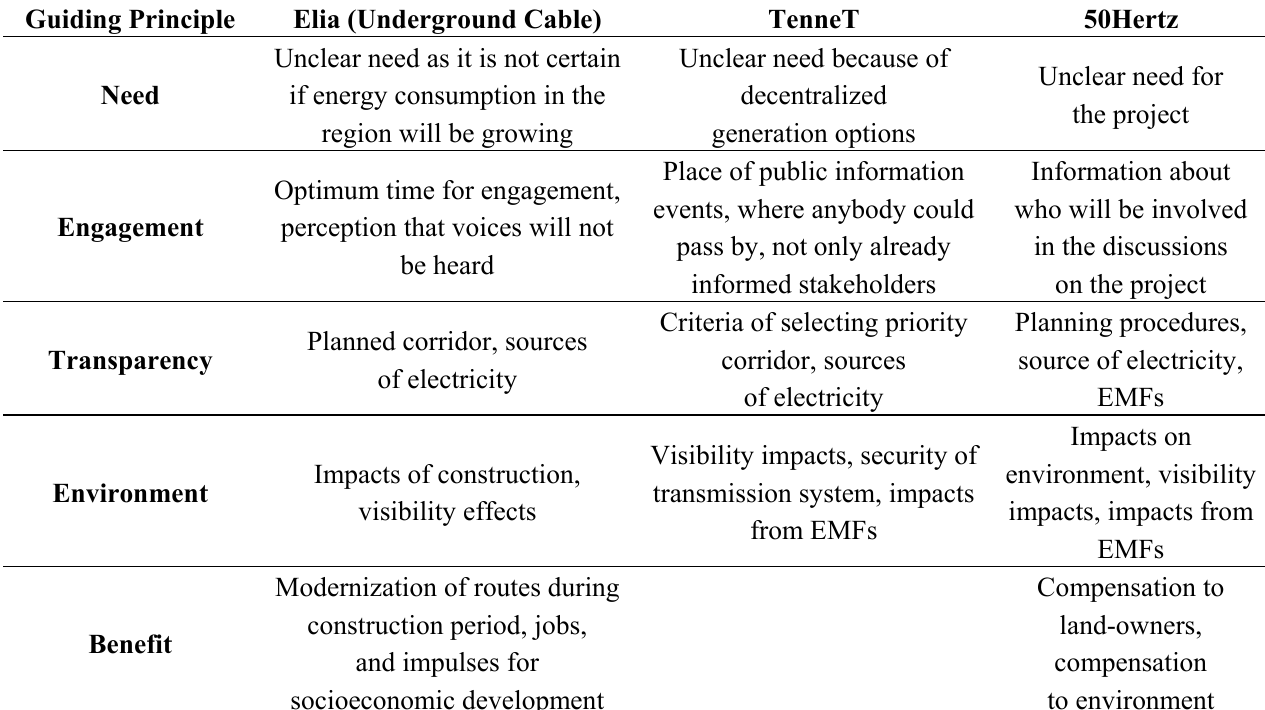
Table 3. Concerns according guiding